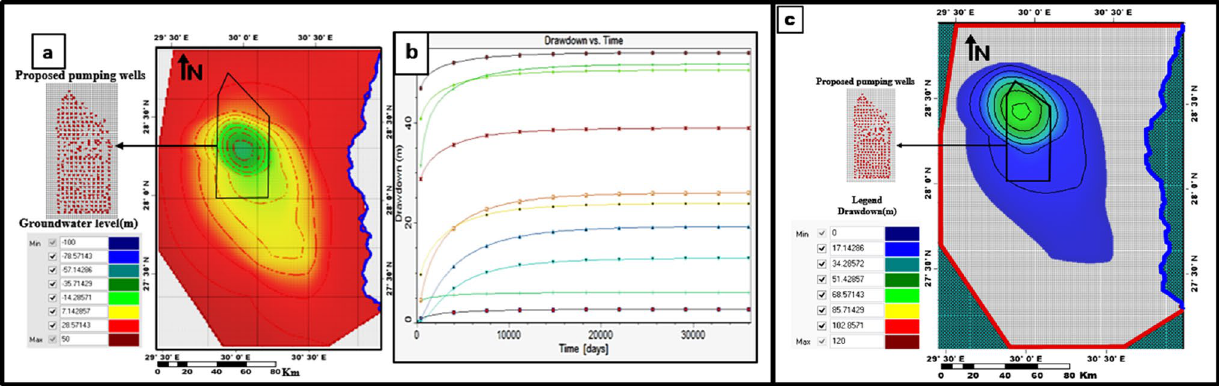
Fig. 17 Model results of the second simulated scenario: a hydraulic head distribution, b drawdown versus time, and c drawdown distribution